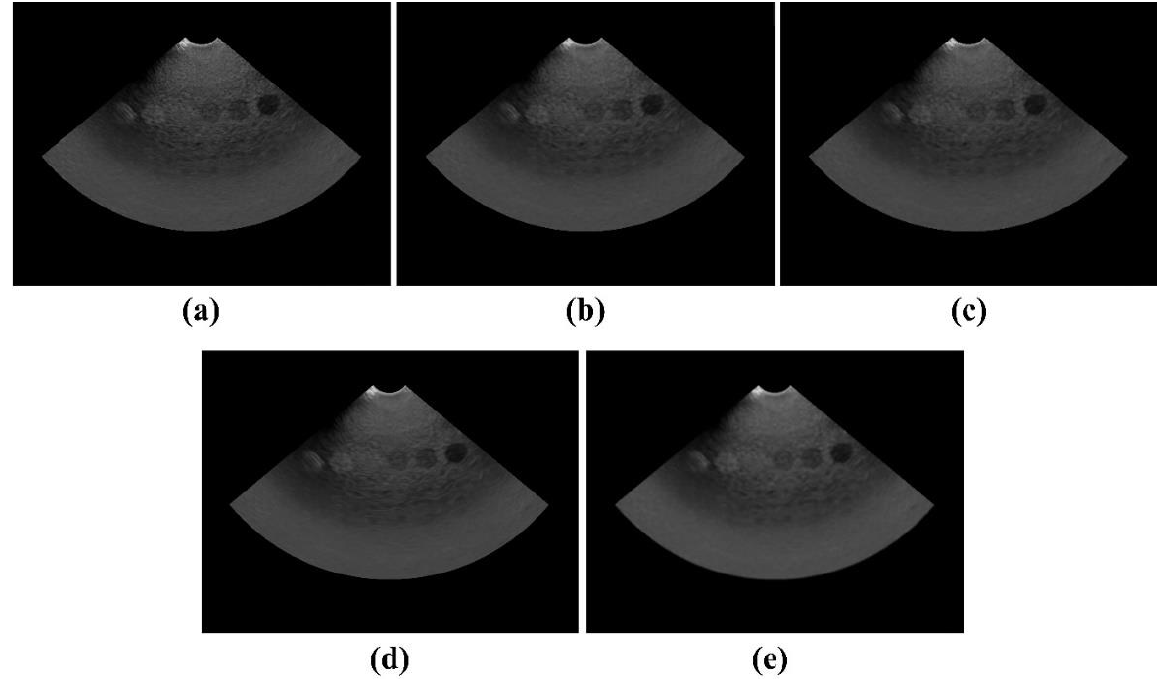
Figure 4. Acquired ATS ultrasound phantom images using ( a ) noisy, ( b ) median filter, ( c ) Wiener filter, ( d ) PGPD, and ( e ) proposed NLM noise-reduction algorithm.